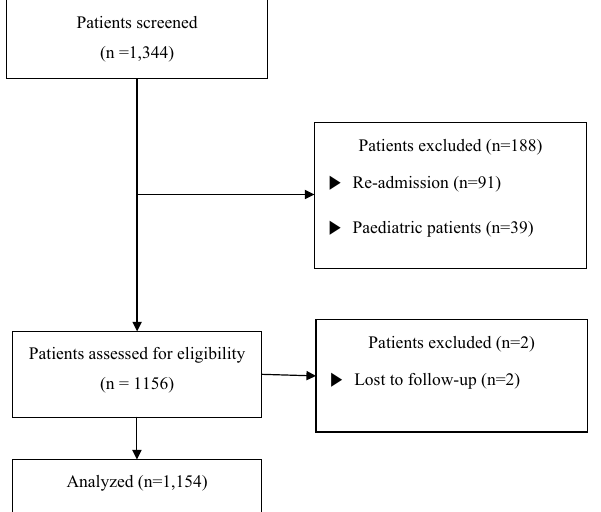
Figure 1. Flowchart of study enrolment.